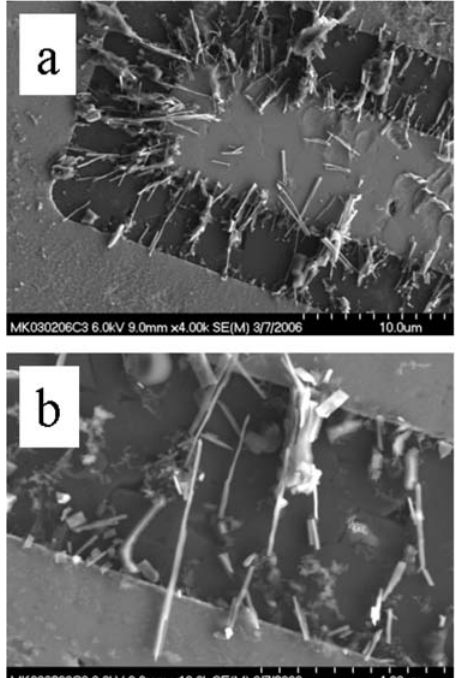
Figure 13. SEM image of (a) varied morphologies produced by harvesting nanowires grown by controlled oxidation. (b) Their unsuitability to bridge opposing electrodes is